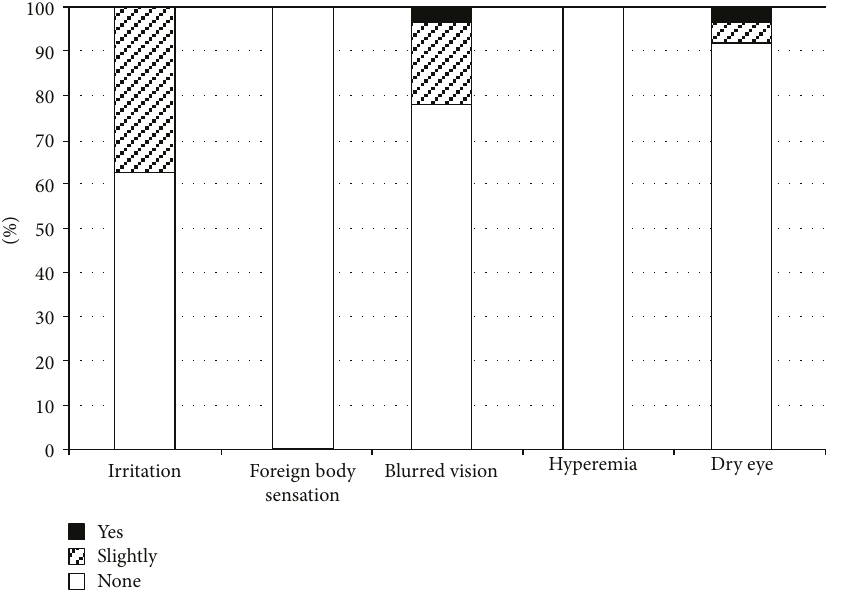
Figure 8: Survey three months after fi xed-combination therapy